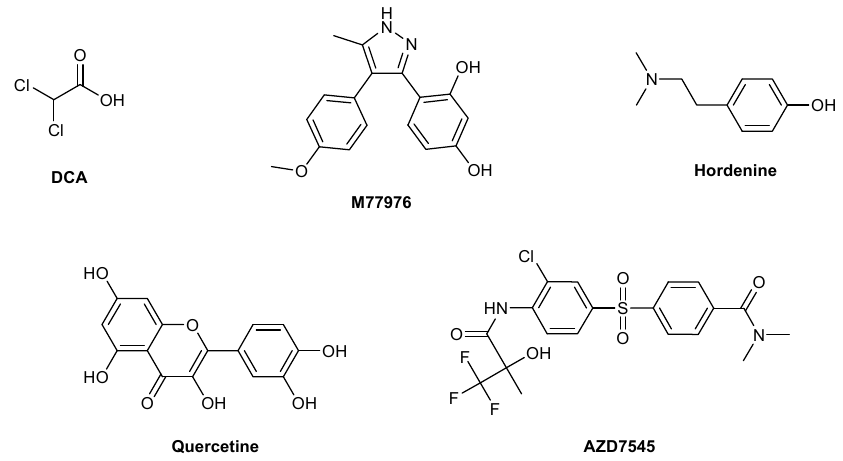
Figure 1. Structures of some representative PDK inhibitors.